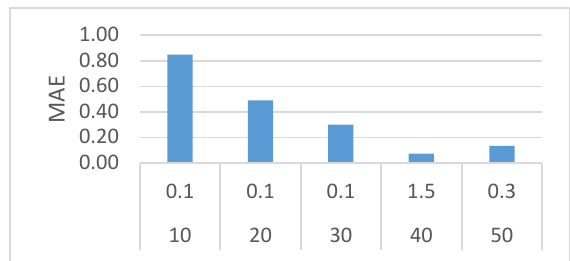
Figure 6. Best value of c according to various values of neighborhood size.